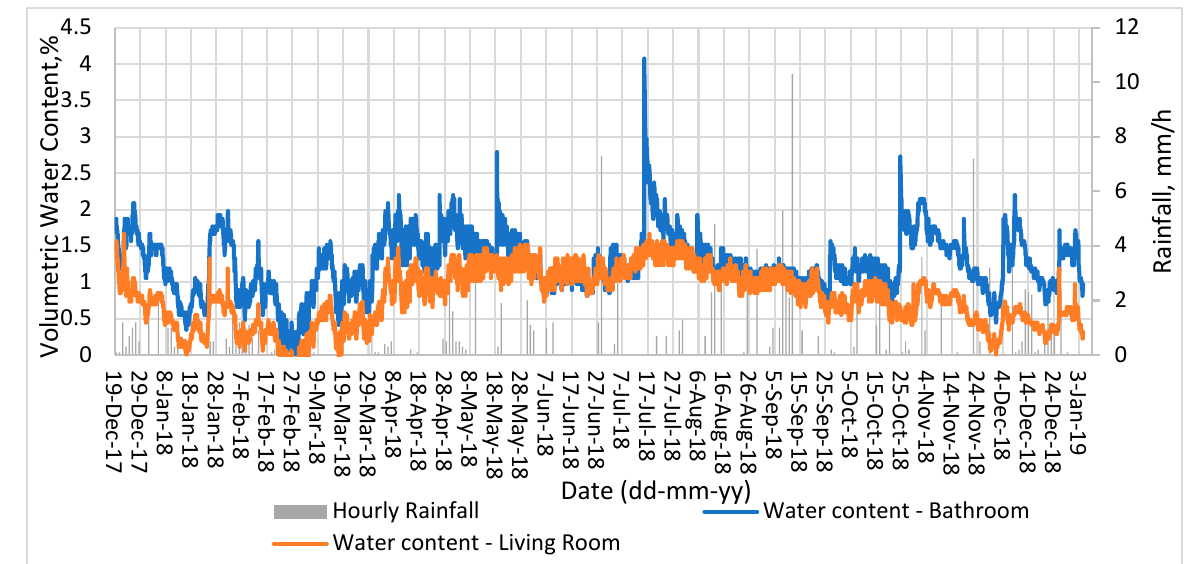
Figure 9. Results of water content measurements and rainfall (mm).